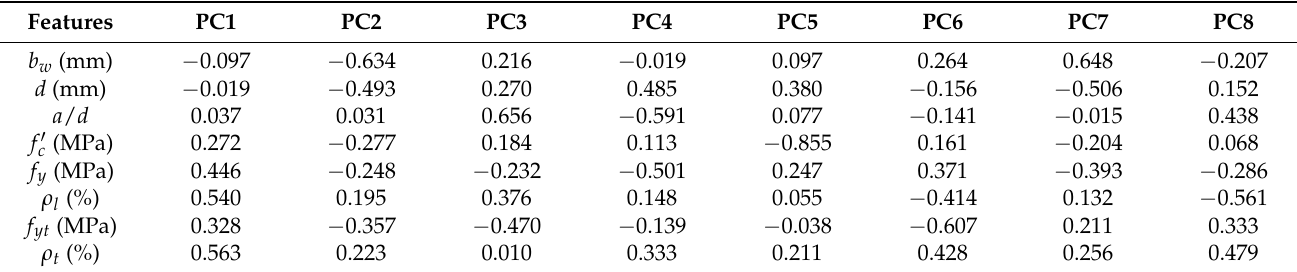
Figure 1. Significance of each principal component (blue bars) and the accumulative importance (red curve). Table 1. Principal components (PC). De-correlated data set X is obtained when this table, V a , is multiplied by the normalized data set X a , i.e., X = X a V a